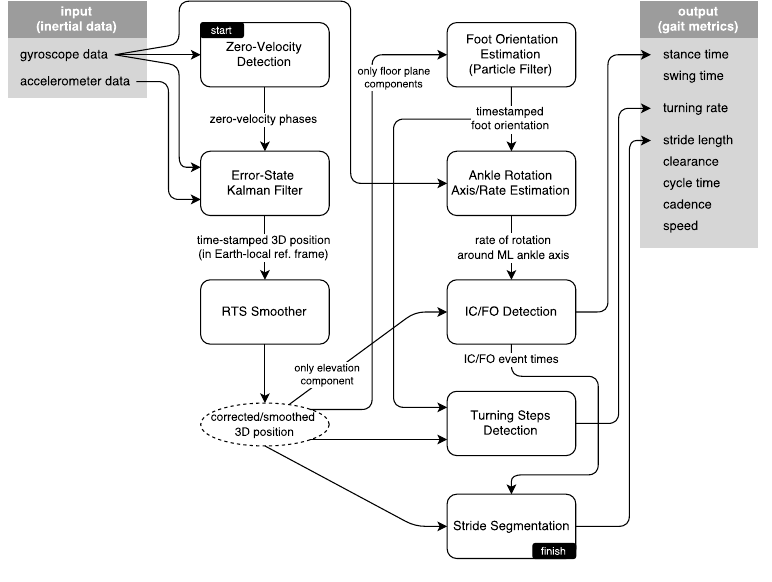
Figure 4. System block